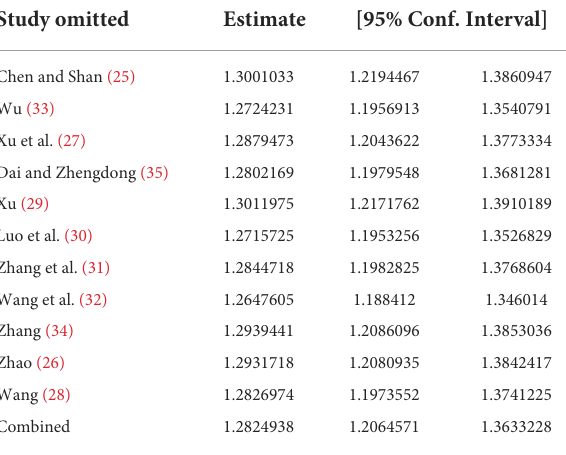
TABLE 6 Sensitivity analysis results of clinical